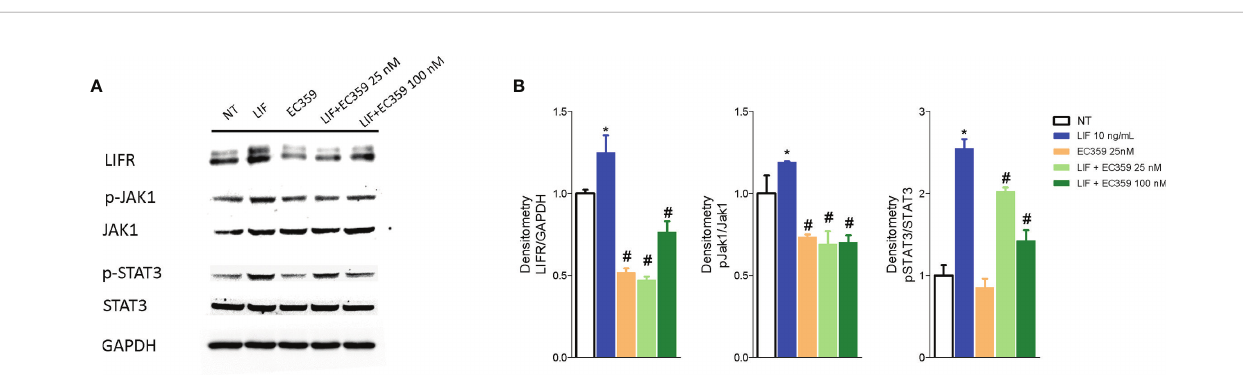
FIGURE 7 | Analysis of JAK-STAT signaling pathway. Representative Western blot analysis of (A) LIFR, JAK1 and phospho-JAK1, STAT3 and phospho-STAT3, and proteins in MKN45 exposed to LIF (10 nM) alone or in combination with EC359 (25 nM and 100 nM) for 20 min. GAPDH was used as loading control. (B) Densitometric analysis demonstrating LIFR expression, phospho-JAK1/JAK1, and phospho-STAT3/STAT3 ratio. The blot shown is representative of another one showing the same pattern. (* represents statistical signi fi cance versus NT, and # versus LIF, p <